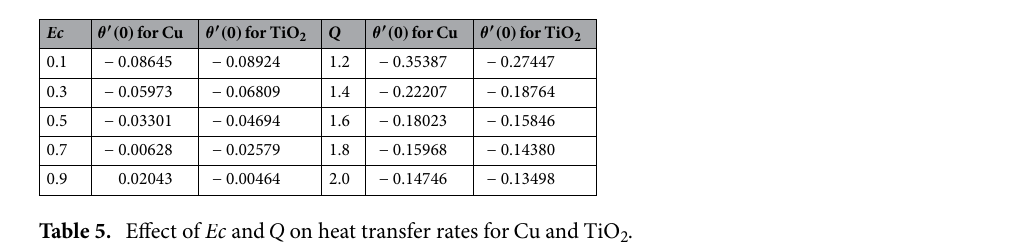
Table 5. Effect of Ec and Q on heat transfer rates for Cu and TiO 2